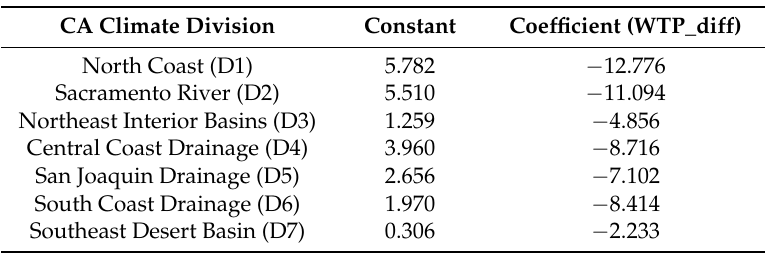
Table 5. Linear regression models estimating DJF precipitation in each climate division of CA using WTP_diff for the 21-year (1995–2015) period.